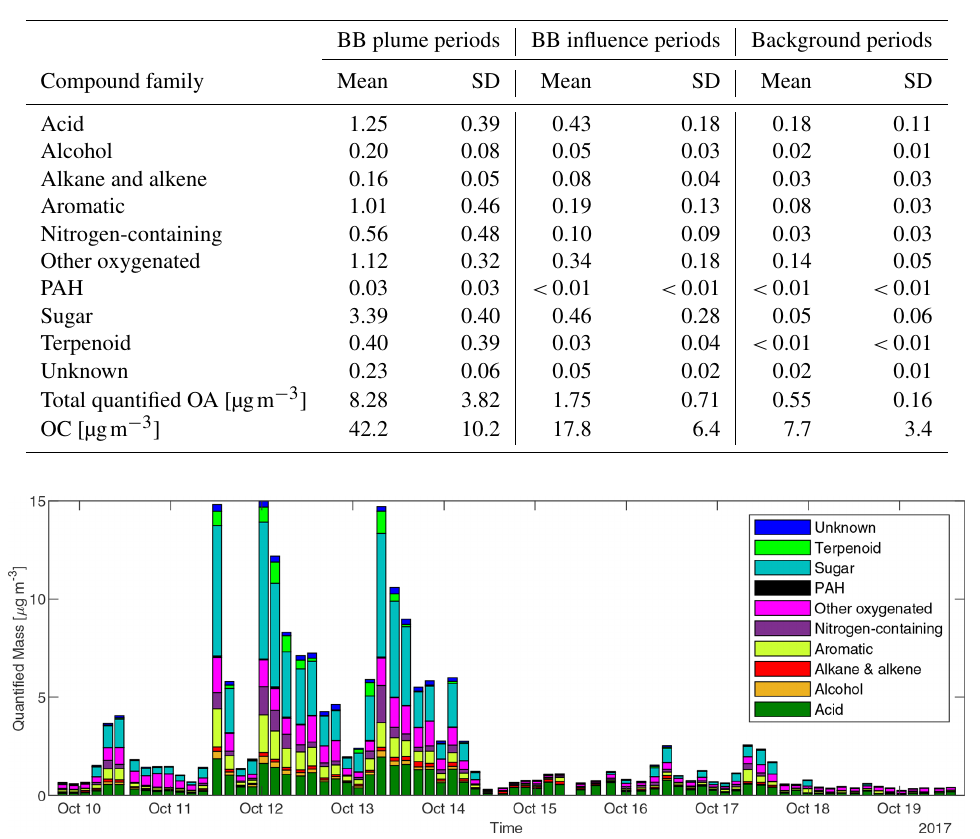
Figure 3. Concentrations of speciated compounds classified by chemical family in each sample. Each stacked bar shows the sum of concen- trations of compounds in each class in a 3 or 4h